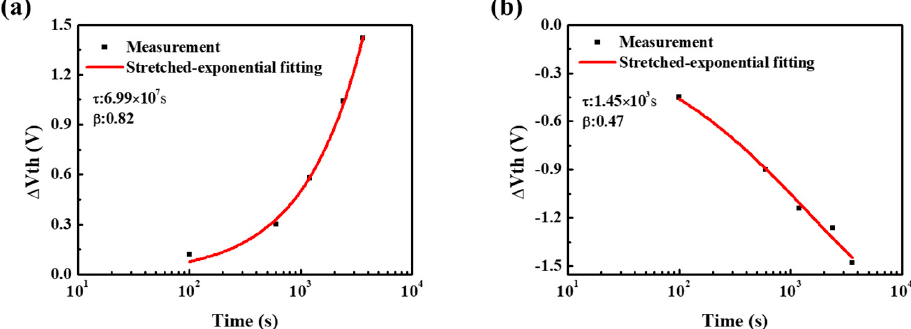
Figure 7. Time evolution of △ V th under different bias stresses: ( a ) PBS and ( b ) NBS. The measured data was well fitted with a stretched-exponential equation in both phases.